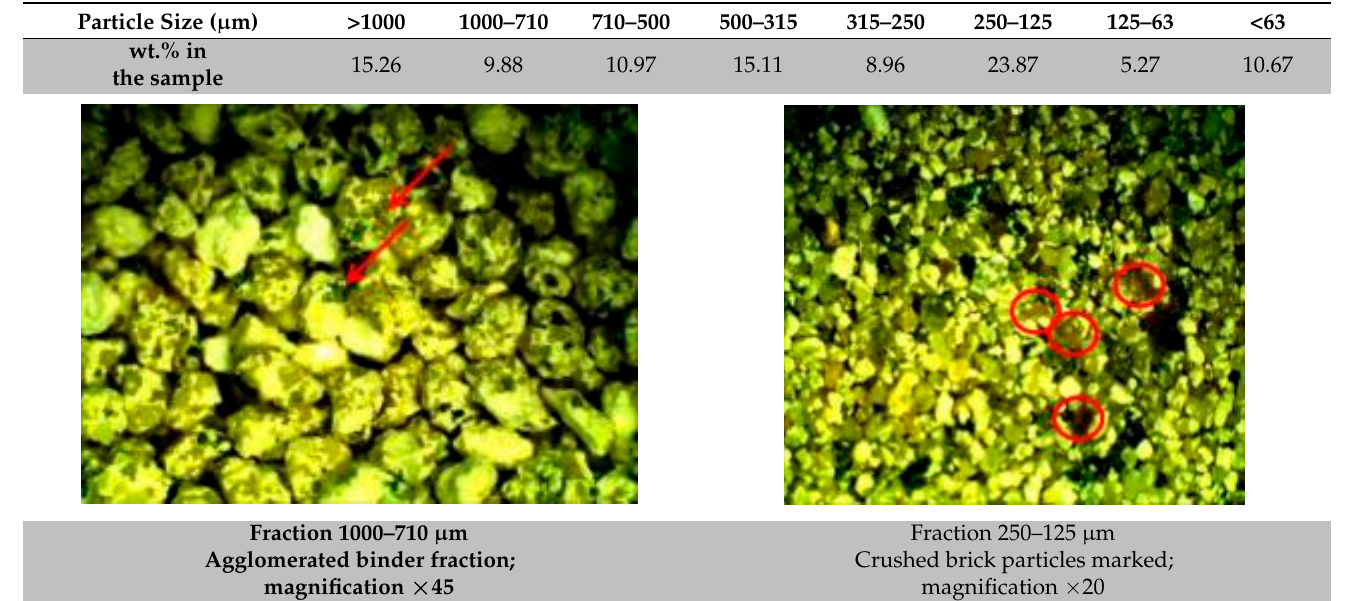
Table 3. Binder-to-aggregate ratio and chemical analyses of historical mortar sample, HM.